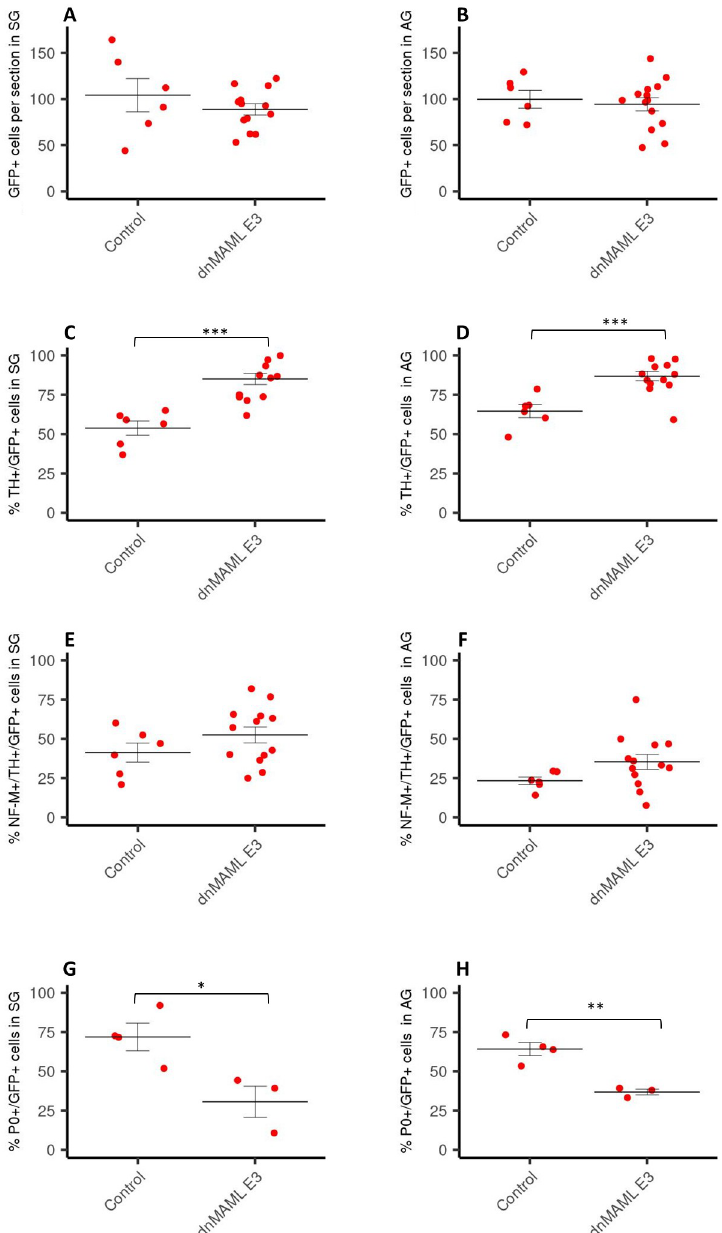
Fig 5. Quantification of cells expressing various markers in SG and AG following electroporation with dnMAML at E3. Amount of GFP-positive cells per section (% of control) in SG (A) and AG (B) of E6 chick embryos after electroporation with dnMAML at E2 with tet-on activation at E3 (control n = 6, dnMAML n = 13). Percentage of TH+/GFP+ cells out of GFP-positive cells in SG (C) and AG (D) of E6 chick embryos after electroporation with dnMAML at E2 with tet-on activation at E3. Amount of NF-M+/TH+/GFP+ cells in SG (E) and AG in E6 (F) chick embryos after electroporation with dnMAML at E2 with tet-on activation on E3 (control n = 6, dnMAML n = 13). Percentage of P0+/GFP+ cells out of GFP-positive cells in SG (G) and AG (H) of E6 chick embryos after electroporation with dnMAML at E2 with tet-on activation on E3 (control n = 4, dnMAML = 3). Data are presented as mean +/- S.EM. � p � 0.05; �� p � 0,01; ��� p � 0,001; n: number of experimental animals. The values used to build the graphs in S4 File.